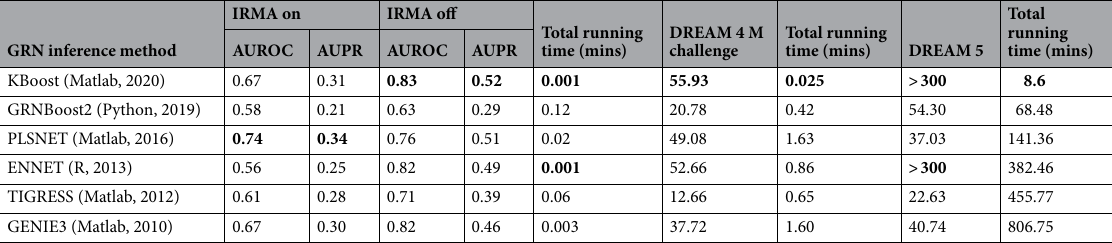
Table 4. Results summary of running time and performance. The best performance in each column is in bold.